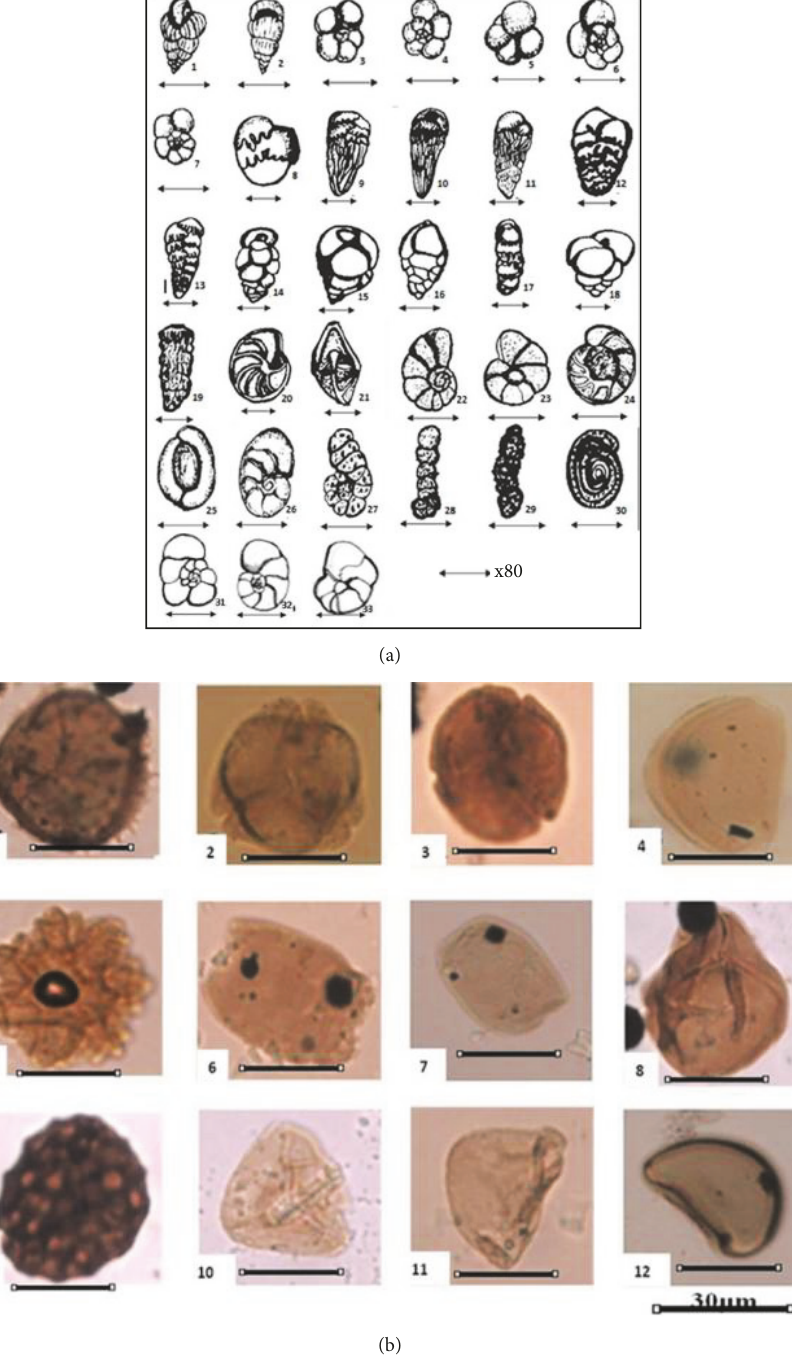
Figure 6: (a) Some common planktic and benthic foraminiferal forms recovered from the Djega outcrop represented by line drawings, not to scale: 1-2 Pseudotextularia elegans (1 side view, 2 edge view), 3-4 Hedbergella planispira (3 umbilical side, 4 spiral side), 5-6 H. monmouthensis (5 umbilical side, 6 spiral side), 7 H. holmdelensis (side view), 8–11 Bolivina afra cf Afrobolivina afra (8 a megalospheric form, probably a juvenile, 9-10 side views, 11 apertural view), 12 and 13 Bolivina explicate (side views), 14-15 Praebulimina robusta (14 side view, 15 edge view), 16 Praebulimina laddi (edge view), 17 Orthokarstenia ewaldi (side view), 18 Praebulimina lata (side view), 19 Orthokarstenia parva (side view), 20-21 Lenticulina secans (20 side view, 21 edge view), 22-23 Planulina nacatochensis (22 spiral side, 23 umbilical side), 24 Gavelinella guineana (spiral side), 25-26 Nonionella robusta (25 spiral side, 26 umbilical side), 27 Ammobaculites subcretacea (side view), 28-29 Ammobaculites coprolithiformis (side views), 30 Haplophragmoides sp . (umbilical side), 31 Epinoides sp. (side view), and 32 and 33 Anomalinoides umboniferus ; (a) spiral view and (b) umbilical view. (b) Photo micrographs of some palynomorphs recovered from the Djega outcrop; 1: Asplenium sp., 2 : Syncolporites marginatus, 3 : Syncolporites marginatus, 4 : Longapertites marginatus, 5 : Ctenolophonidites costatus, 6 : Retidiporites magdeleinsis, 7 : Retidiporites magdelensis, 8 : Acrostichum aureum, 9 : Klukisporites pseudoreticulatus, 10 : Cyathidites sp. , 11 : Cyathidites sp. , 12: Laevigatosporites